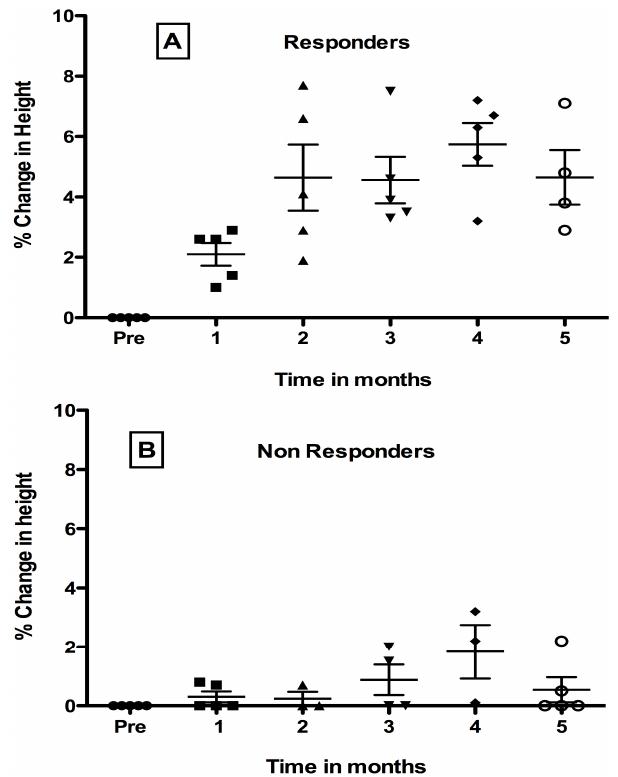
Figure 1. Effect of Oral Probiotic Lp299v on Height in Congenital HIV-1 Infection. Data show mean percent change ± SD. from mean baseline height for the 4-month pretreatment period compared to each post treatment month. For responders (panel A) but not non-responders (panel B), variance was significant. Mean height increased in